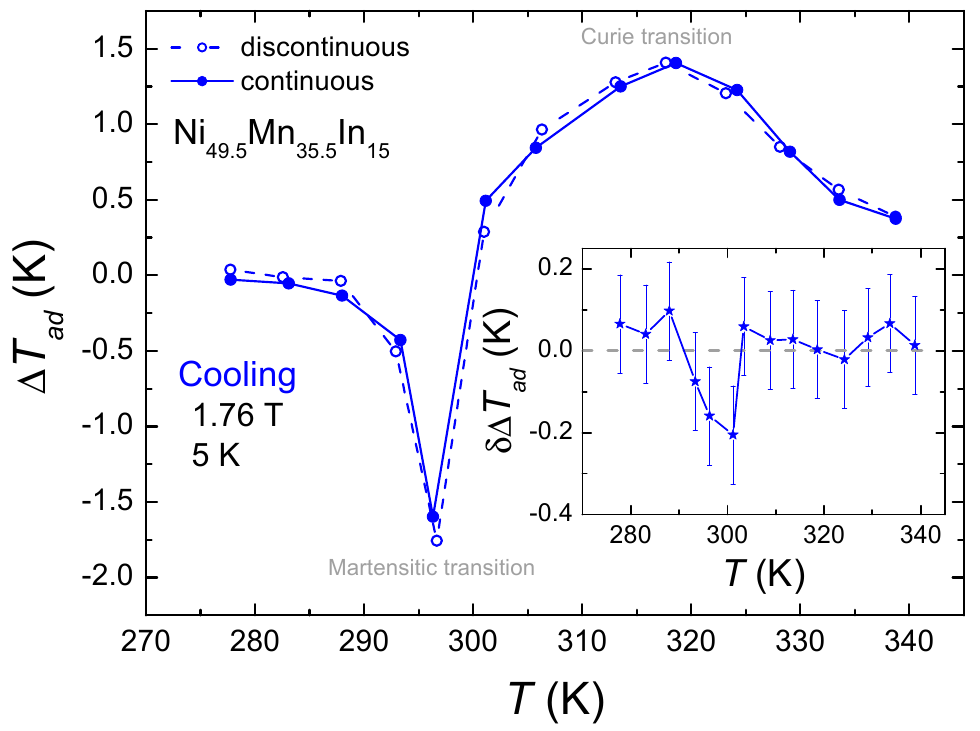
Figure 2. Temperature dependence of the adiabatic temperature change ( Δ T ad ) of Ni 49.5 Mn 35.5 In 15 sample using discontinuous and continuous cooling protocols (open and solid symbols, respectively) with a temperature step of 5 K. Inset: differences between both Δ T ad curves ( δΔ T ad ).